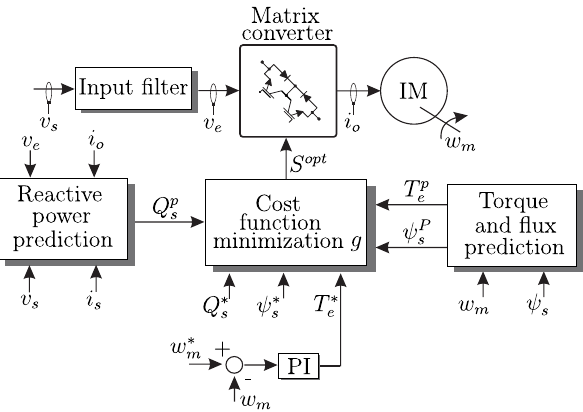
Figure 11. Predictive torque and flux control block